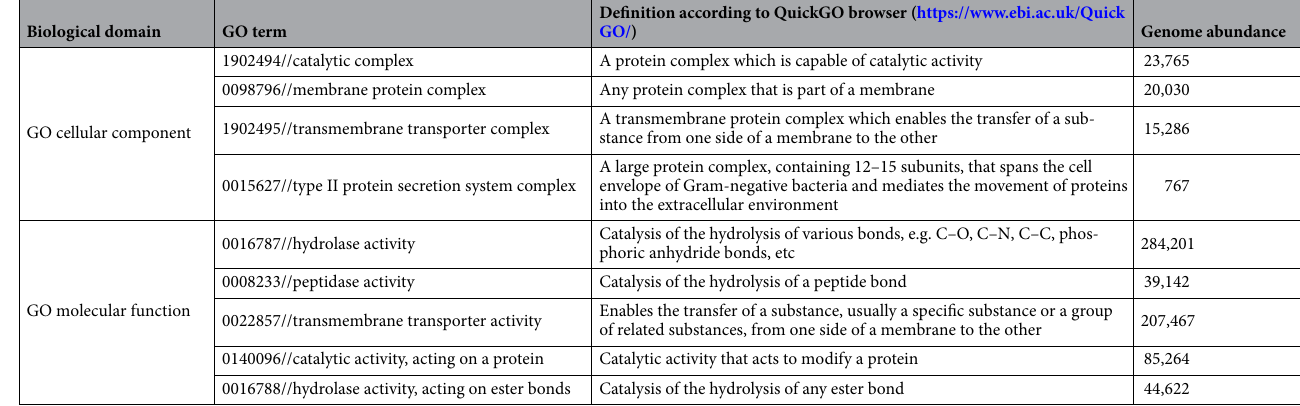
Table 2. Selected GO terms of annotated P. psychrophila KM02 genome.